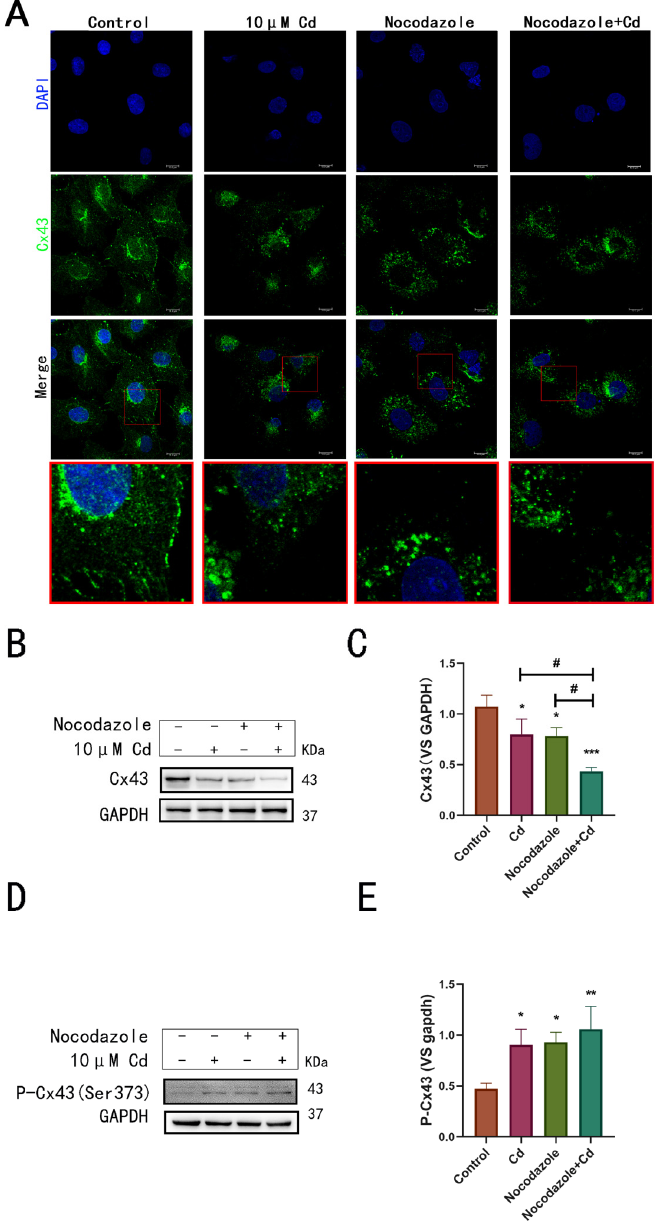
Figure 2. Microtubule damage from Cd toxicity promotes the internalization of Cx43 in hepatocytes: ( A ) Immunofluorescence intracellular distribution of Cx43 after the combined administration of Cd and the microtubule inhibitor nocodazole. Scale bar = 10 µ m; ( B , C ) Analysis of Cx43 level after combined treatment with Cd and nocodazole using Western blotting. * p < 0.05 compared to the control group; *** p < 0.001 compared to the control group; # p < 0.05 compared to the Cd group; ( D , E ) Analysis of P-Cx43 (Ser373) levels after combined treatment with Cd and nocodazole using immunoblotting. * p < 0.05 compared to the control group; ** p < 0.01 compared to the control group.